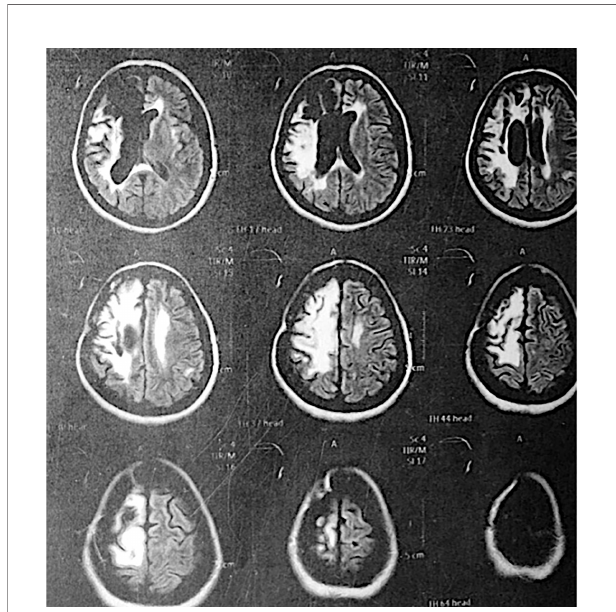
FIGURE 1 | MRI of the patient years after surgery removal of the astrocytoma. An area of right frontoparietal encephalomalacia is observed with retraction of the frontal horn of the right lateral ventricle with slight perilesional